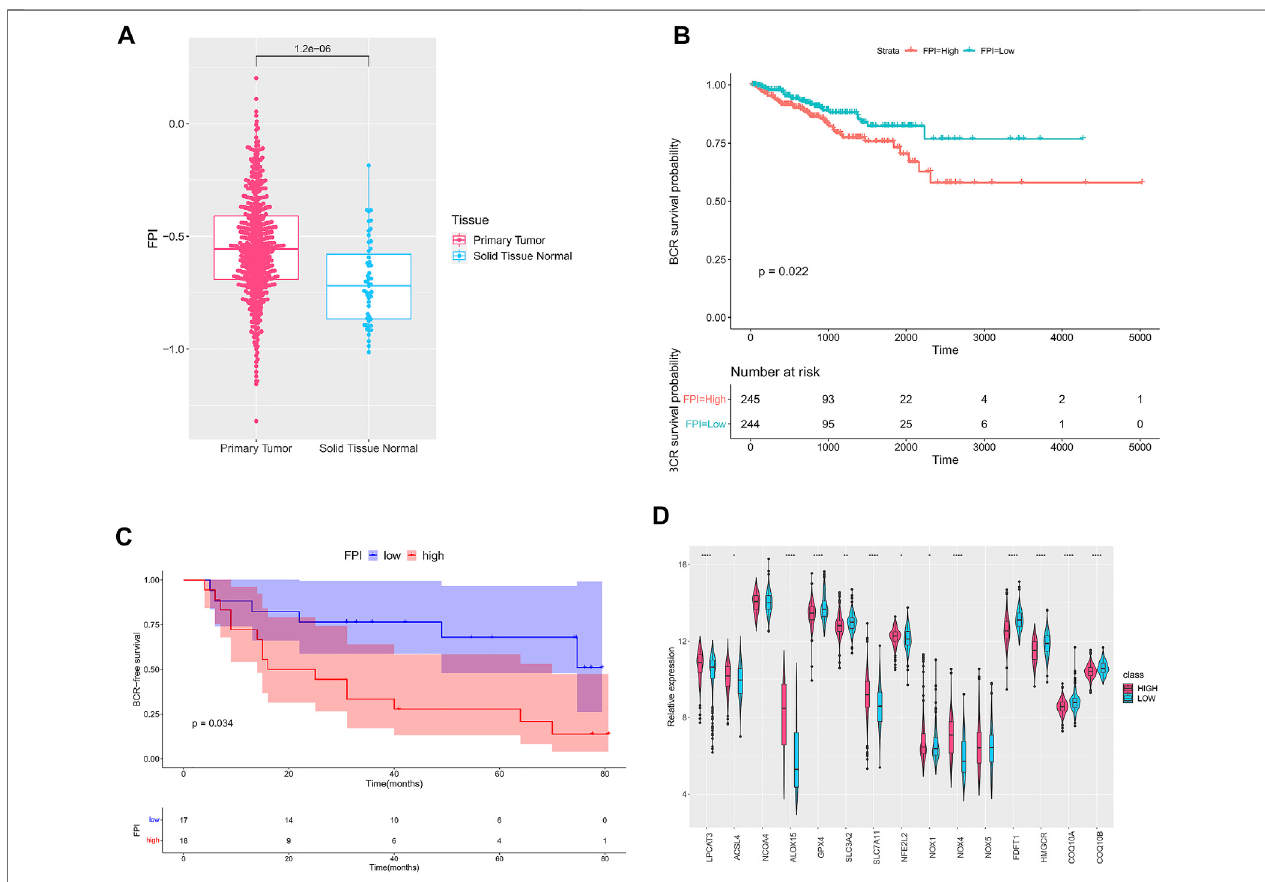
FIGURE1| FerroptosisinPCa. (A) FPIintumor andadjacenttissues; (B) Kaplan – MeiercurveoftheFPI-highgroupandFPI-lowgroupinTCGA; (C) Kaplan – Meier curve of the FPI-high group and FPI-low group in GSE46602; (D) relative expression of FRGs in two groups.